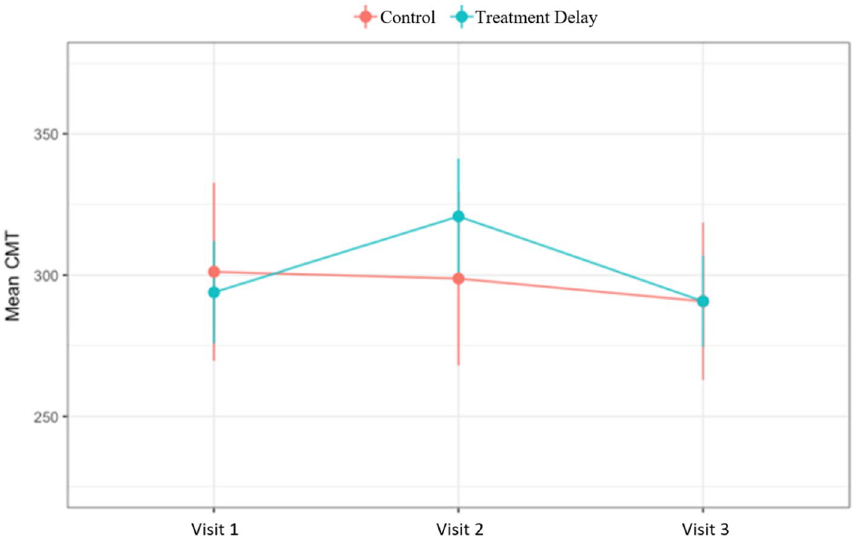
Figure 2. Change in CMT over time. Demonstrates the change in CMT across each visit for both the treatment delay group and the control